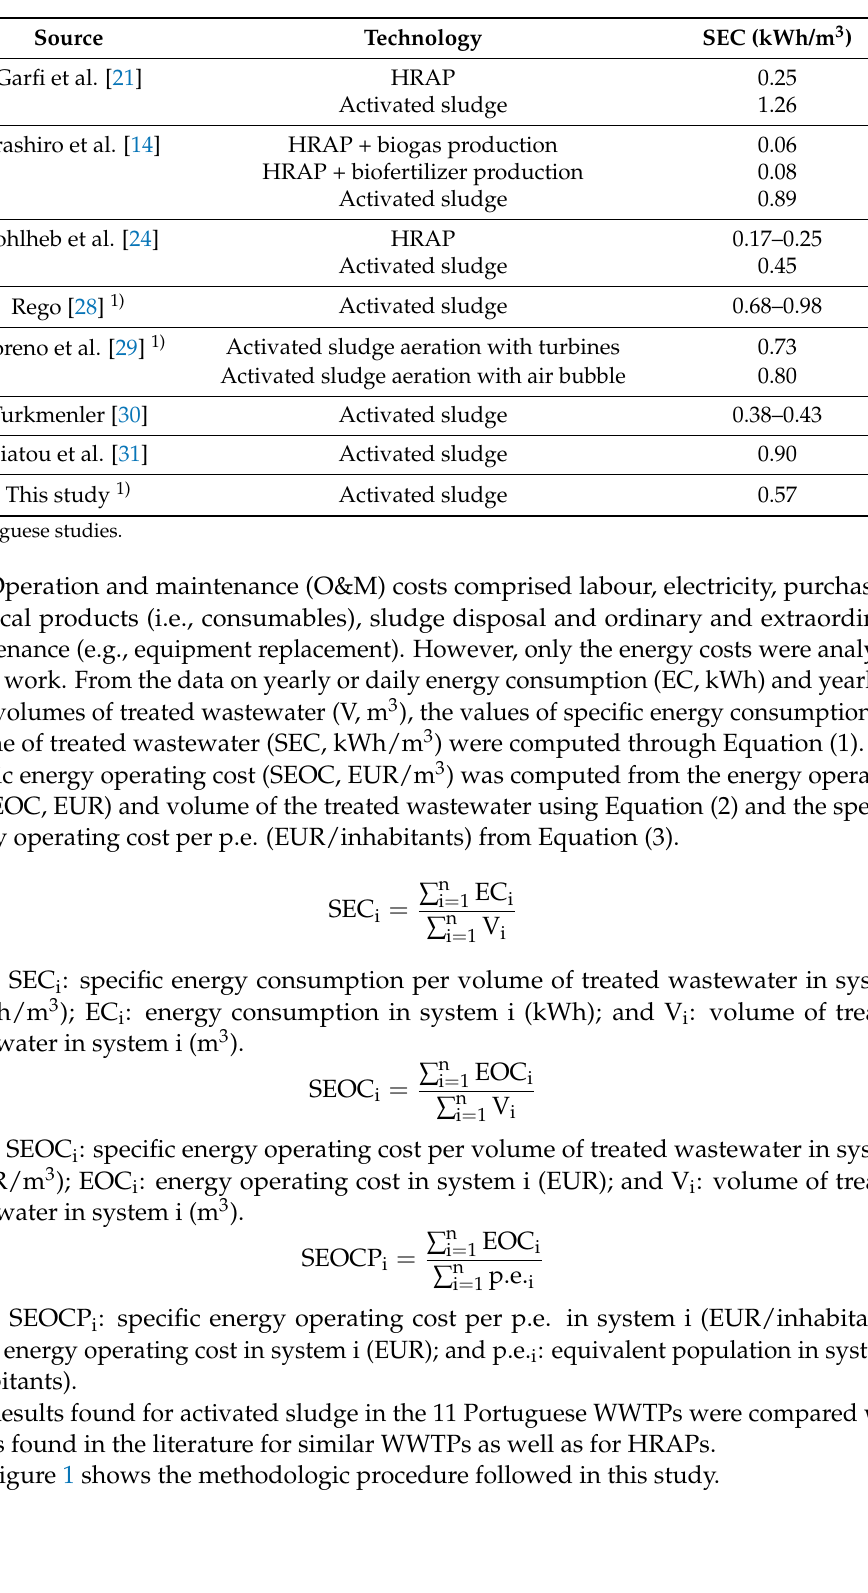
Table 1. Specific energy consumption (SEC) for activated sludge and HRAP